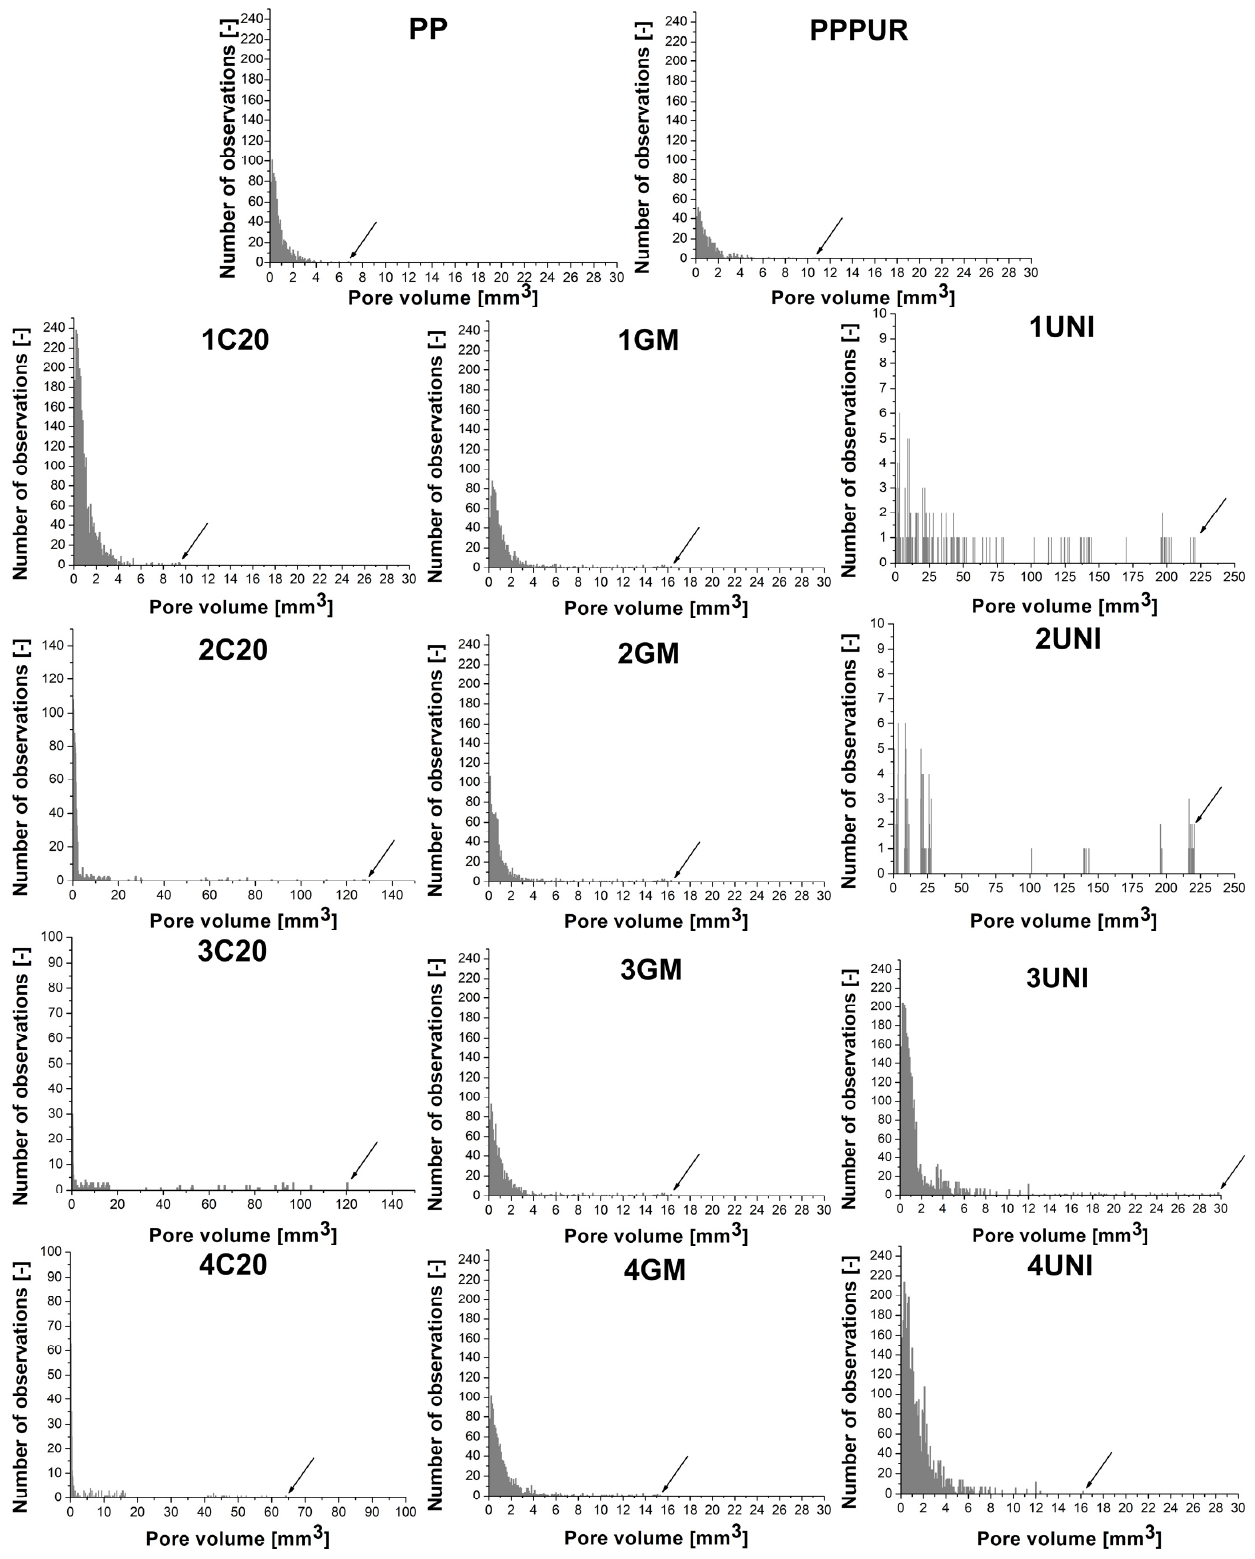
Figure 4. Histograms showing pore volume distribution for prepared samples (arrows indicate the maximum pore volume).